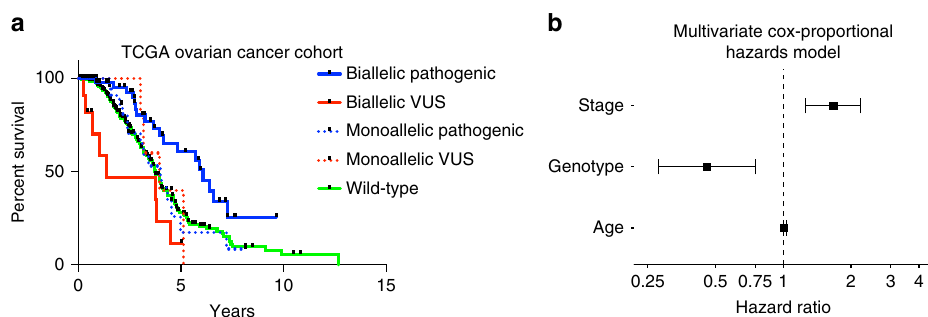
Fig. 2 Overall survival (OS) in TCGA ovarian cancer patients who received platinum-based therapy. a Bi-allelic alterations in HR-related genes are associated with signi fi cantly longer overall survival (OS, p = 0.005; log-rank test). b Forest plot showing results from a multivariate Cox proportional- hazards model adjusting for stage (continuous: I, II, III, IV) and age (continuous) demonstrates that bi-allelic pathogenic alterations are associated with signi fi cantly longer overall survival (hazard ratio (HR) = 0.46, 95% con fi dence interval (CI) = 0.28 – 0.75, p = 0.002, Genotype is a categorical variable, bi-allelic vs. other). Stage (HR = 1.67, 95% CI = 1.25 – 2.21, p < 0.001) and age (HR = 1.01, 95% CI 1.00 – 1.03, p = 0.02) are also associated with outcome